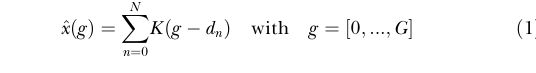
Number of Tumors Screens